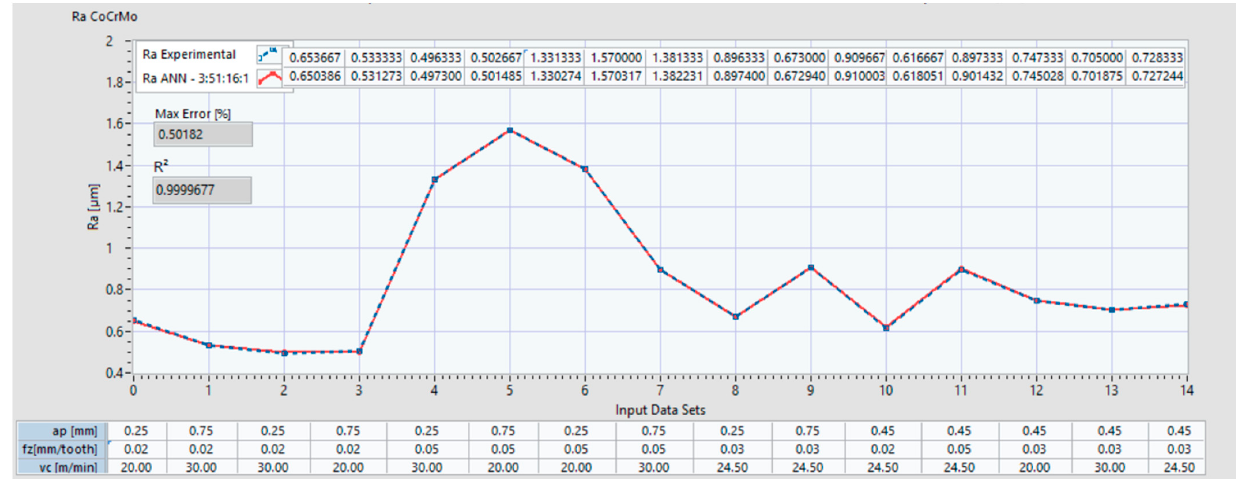
Figure 12. Ra comparison between experimental data and ANN predictions with architecture 3:51:16:1 for Co–28Cr–6Mo.